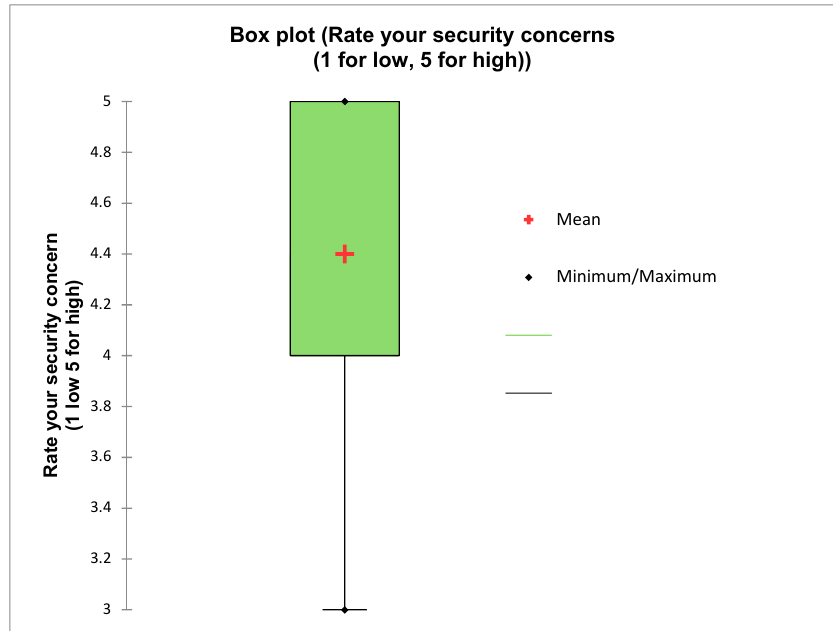
Figure 6. Box plot, showing high-security concerns by smart TV viewers.